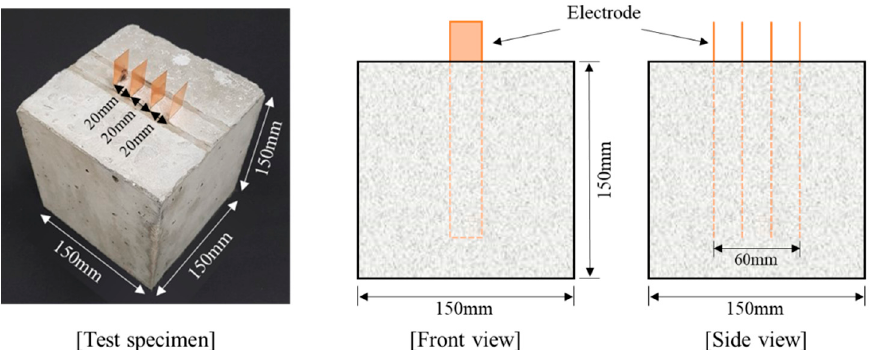
Figure 1. Sieve analysis of the aggregates.